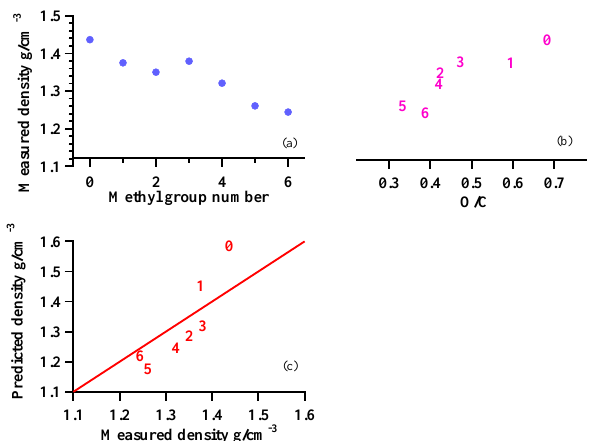
Figure 5. Relationship between (a) SOA density and methyl group number, (b) SOA density and O/C, and (c) predicted and measured density from monocyclic aromatic hydrocarbon photooxidation un- der low NO x (number mark represents number of methyl groups on aromatic hydrocarbon